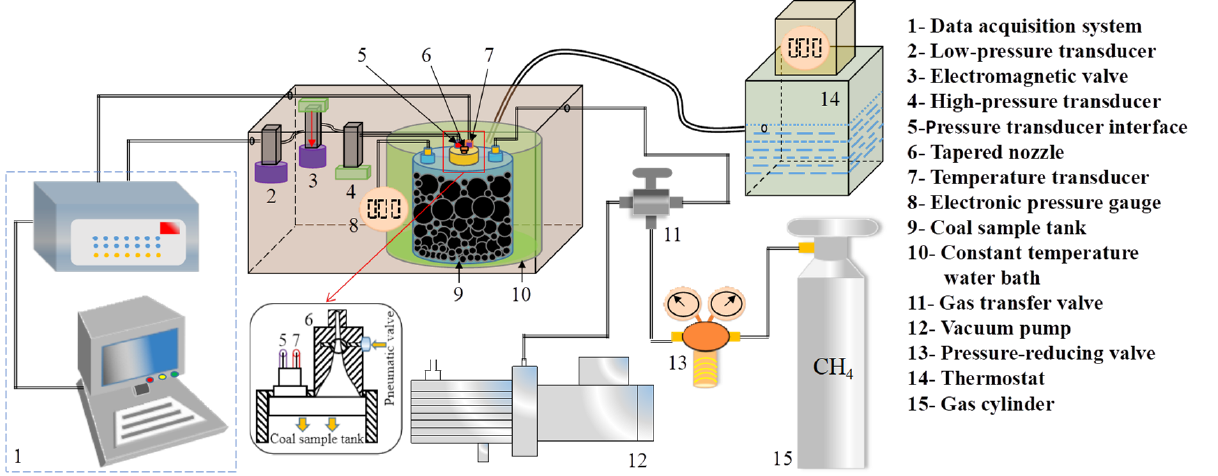
Figure 1. Schematic diagram of the test device.